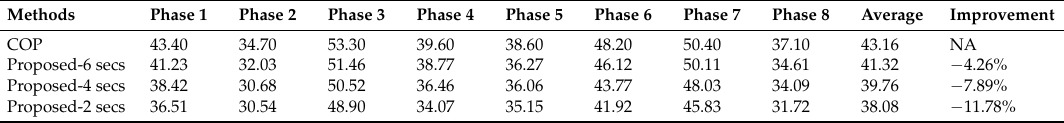
Table 3. The average vehicle delay of each phase (volume level is 3500